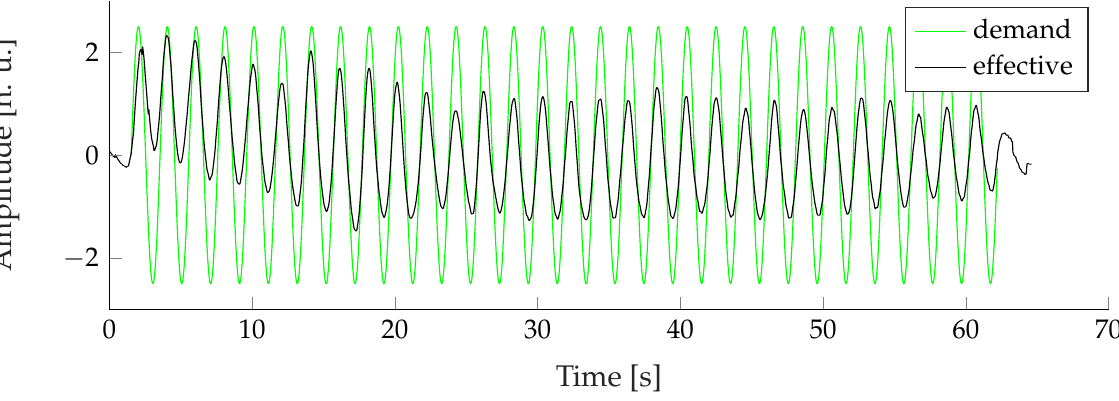
Figure 7. The recorded Kussmaul patterns were excluded from the dataset because of a big difference between demanded respiratory activity and the mean effective respiratory response of all